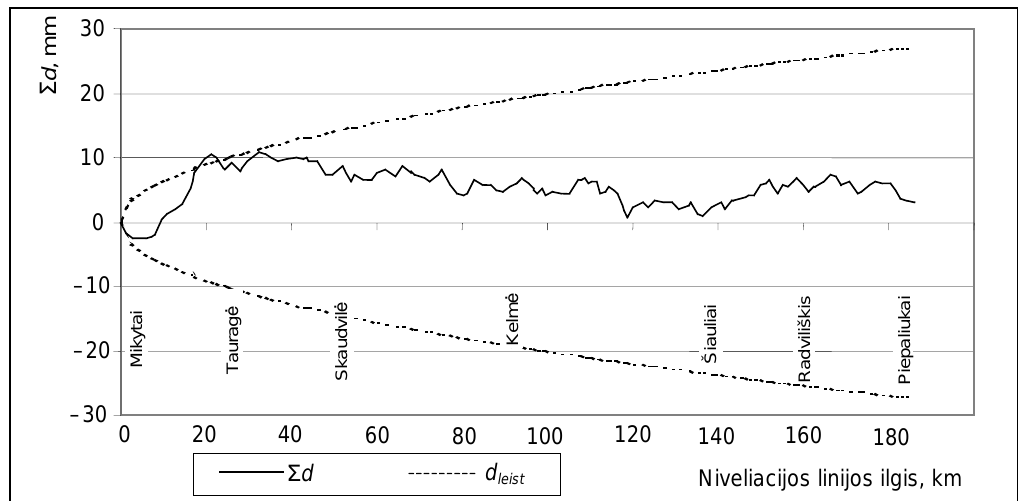
Fig 4. Accumulation of heights differences incoincidences of the 2002 year